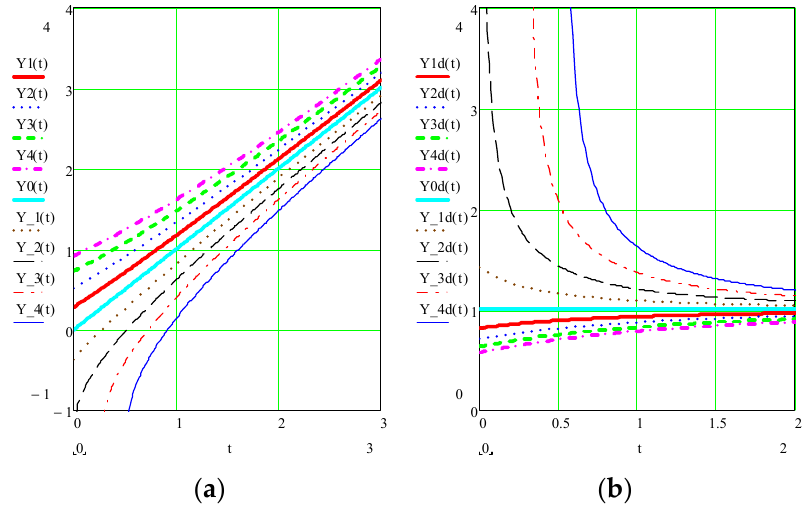
Figure 1. Example of graphs of cross sections of a structural function ( a ) and its derivative ( b ) for various fixed 𝑛 .